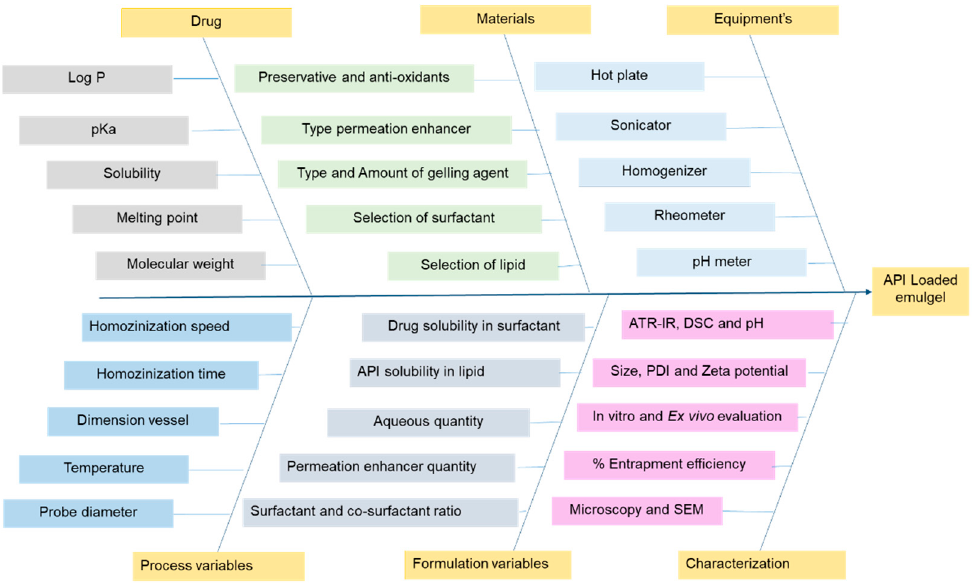
Figure 4. Ishikawa diagram illustrated the potential CMAs and CPPs that effect the CQAs of API- loaded emulgel formulation .